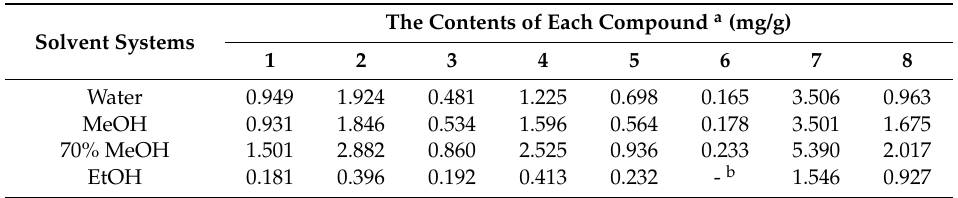
Table 1. The investigation of different extraction solvents.